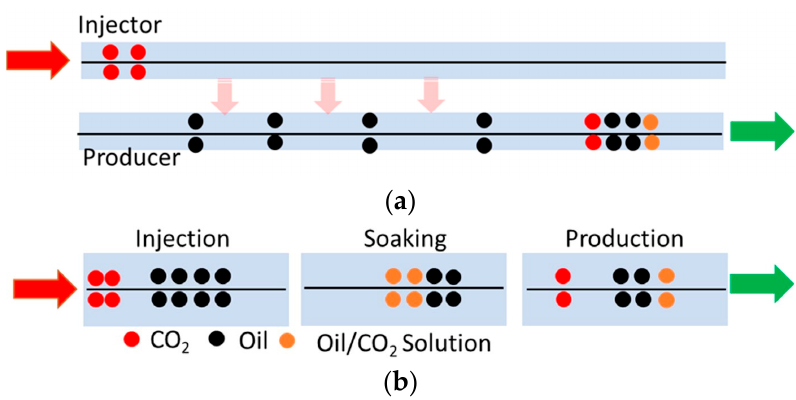
Figure 1. CO 2 EOR strategies. ( a ) Continuous injection process; ( b ) CO 2 HnP strategy. The red and green arrows, respectively, represent gas injection and oil production.